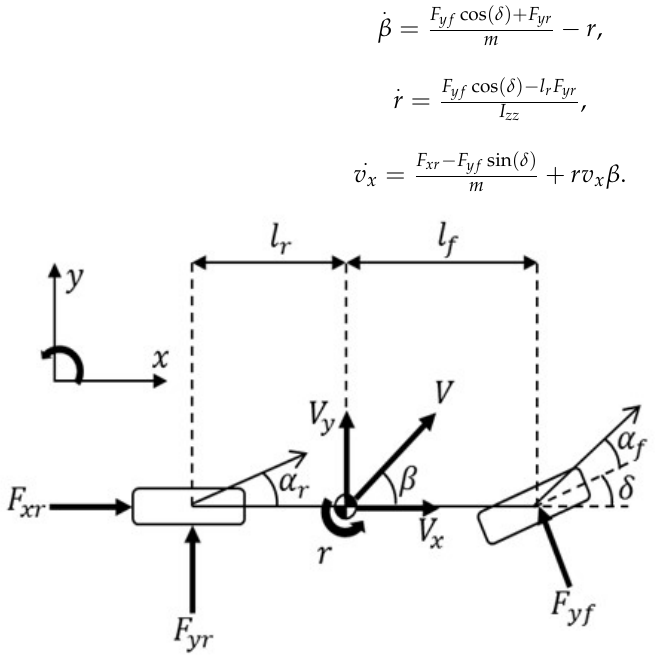
Figure 3. Bicycle model for describing the horizontal motion of the vehicle.